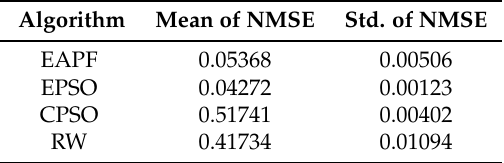
Table 4. Statistic results of the estimated gas distribution maps at final time step in the outdoor